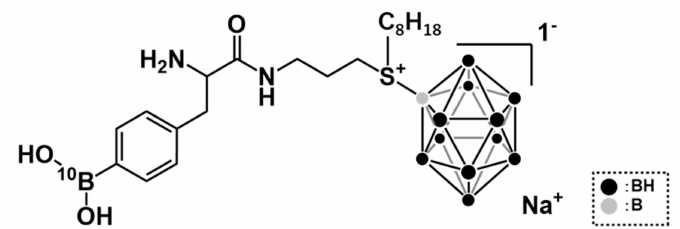
Figure 1. The chemical structure of boronophenylalanine–amide alkyl dodecaborate